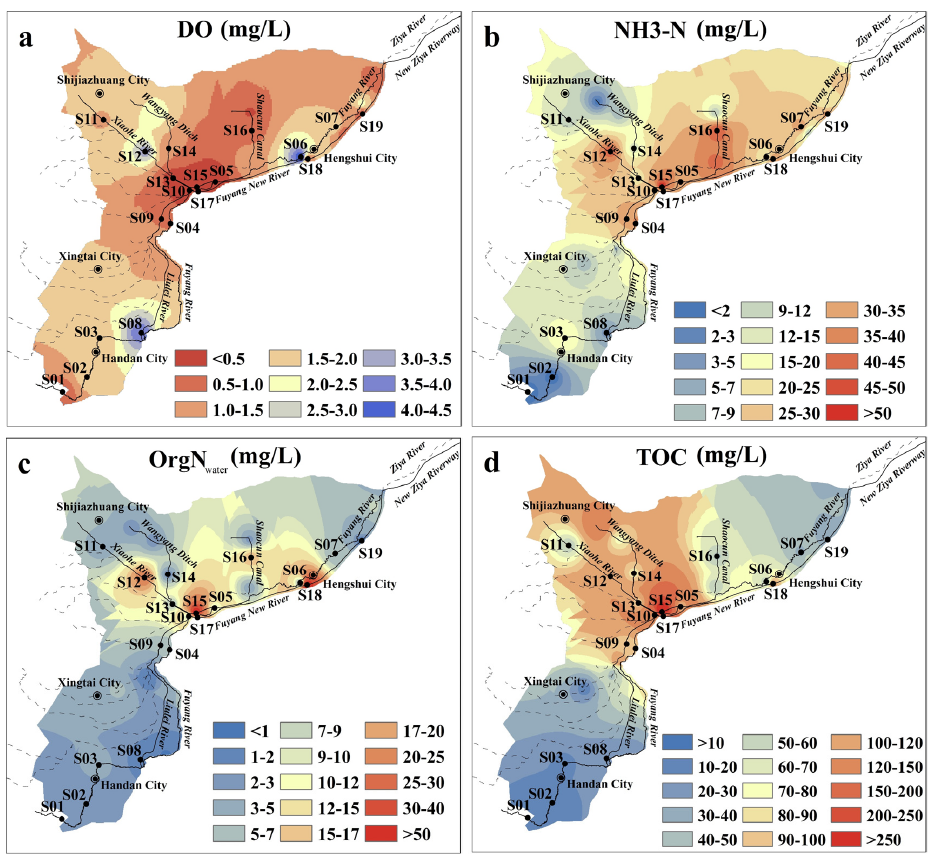
Figure 2. Concentrations of ( a ) DO; ( b ) NH 3 -N; ( c ) OrgN water ; and ( d )TOC in surface water samples of the plain region of the Ziya River Watershed.